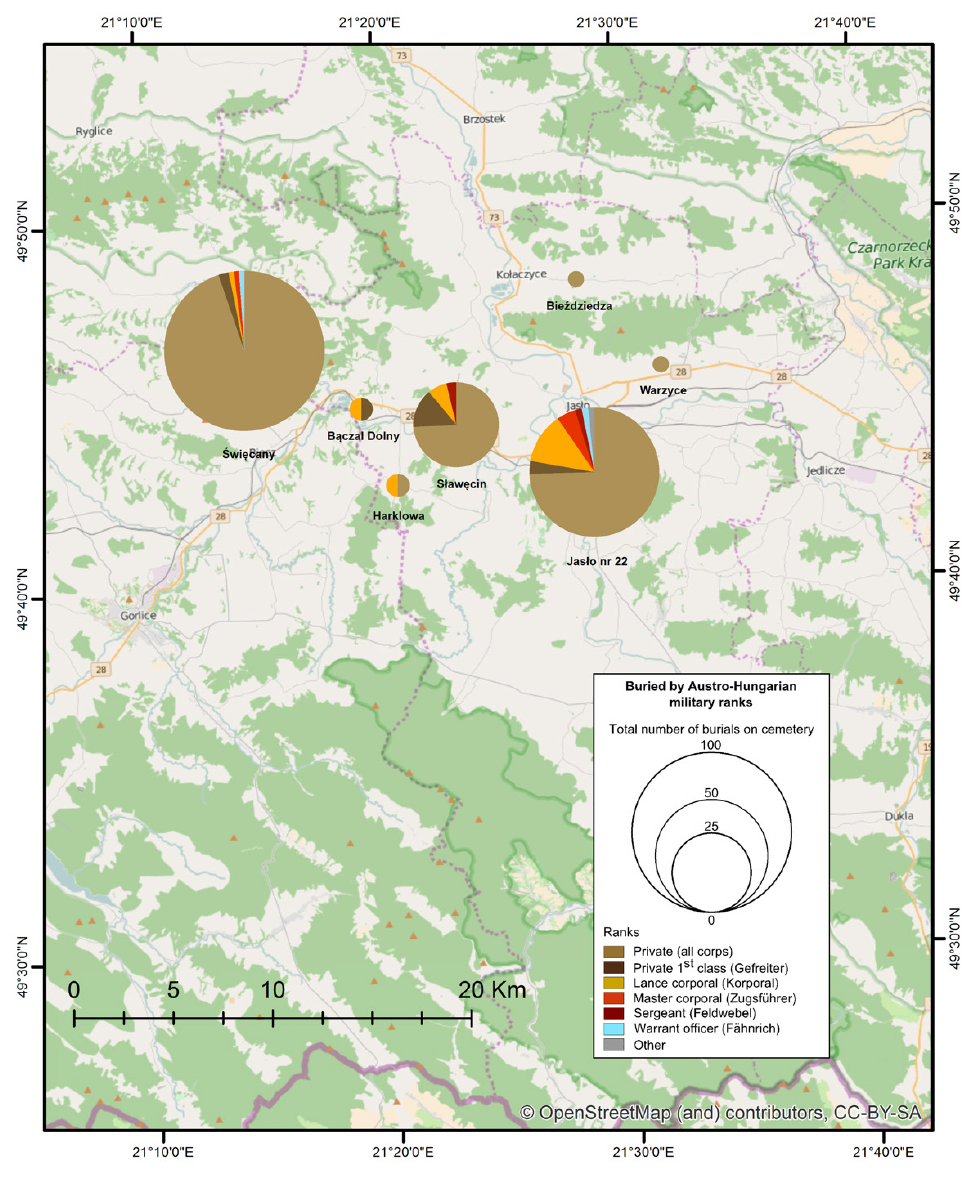
Fig. 5. Buried soldiers of the Austro-Hungarian army by military